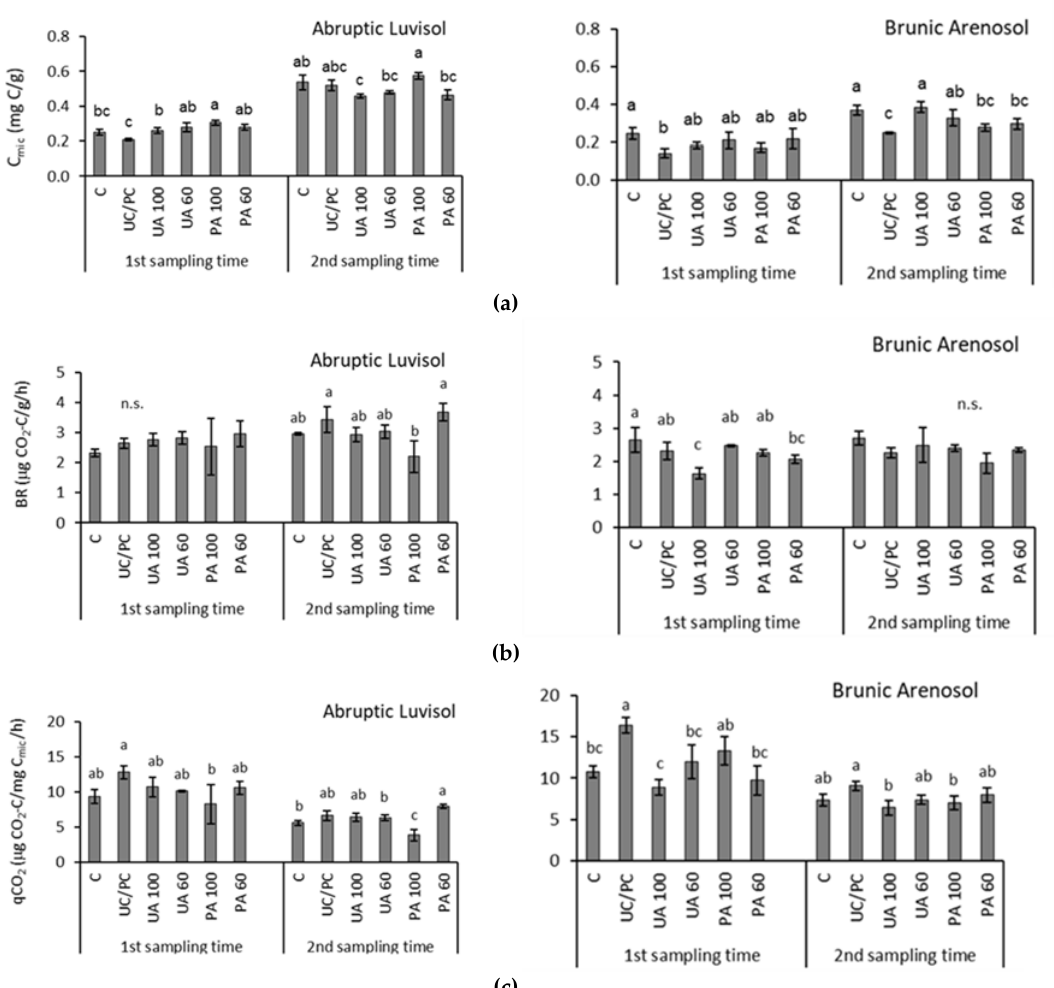
Figure 2. Microbial indicators of ( a ) soil microbial biomass (C mic ), ( b ) basal respiration (BR), and ( c ) metabolic quotient (qCO 2 ) in Abruptic Luvisol and Brunic Arenosol collected on two dates after fertilization: I st sampling time (one week after the application of bio- and fertilizers), and II nd sampling time (six months after fertilization). Tested variants: C—control without fertilization, UC / PC—Polifoska and urea, UA 100—urea in full dose enriched with microorganisms, UA 60—urea in reduced dose enriched with microorganisms, PA 100—Polifoska in full dose enriched with microorganisms, PA 60—Polifoska in reduced dose enriched with microorganisms (average values ± standard deviation; n = 3). Di ff erent letters indicate significant di ff erences; ANOVA, Tukey HSD test, separately for each soil and for each sampling time, p < 0.05.